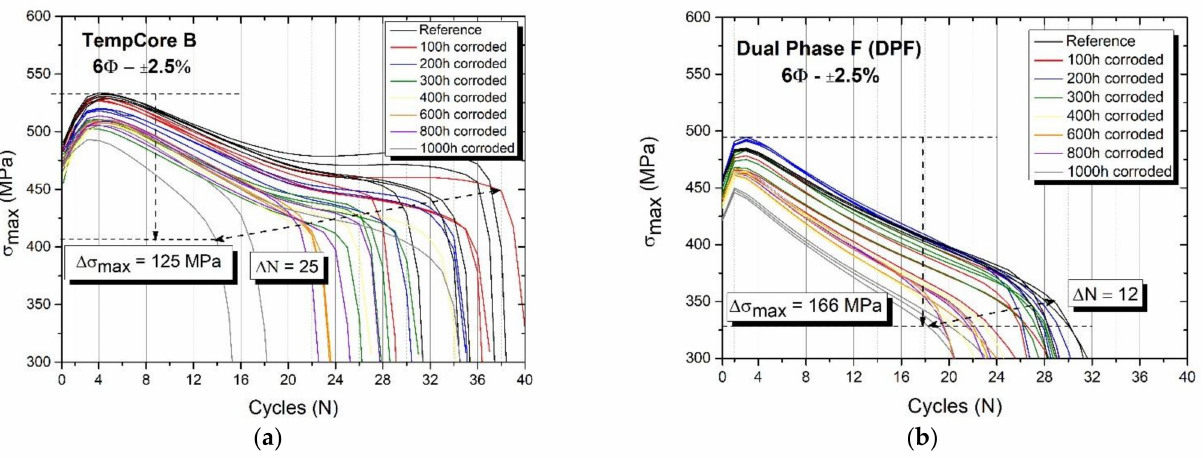
Figure 14. Diagrams of maximum stress σ max toward number of cycles N for ± 2.5% strain controlled for ( a ) Tempcore Steel B and ( b ) Dual Phase Steel F